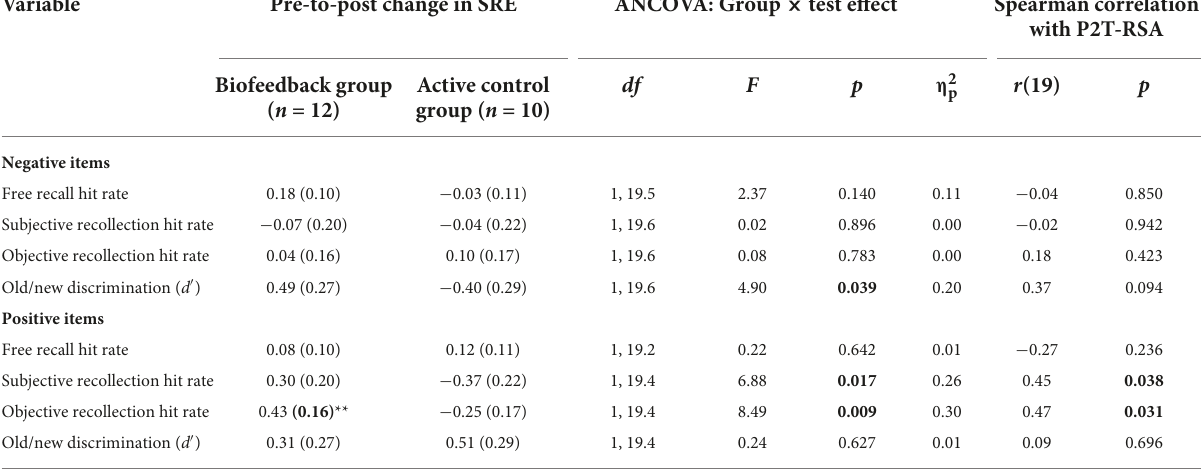
TABLE 6 Self-reference effect